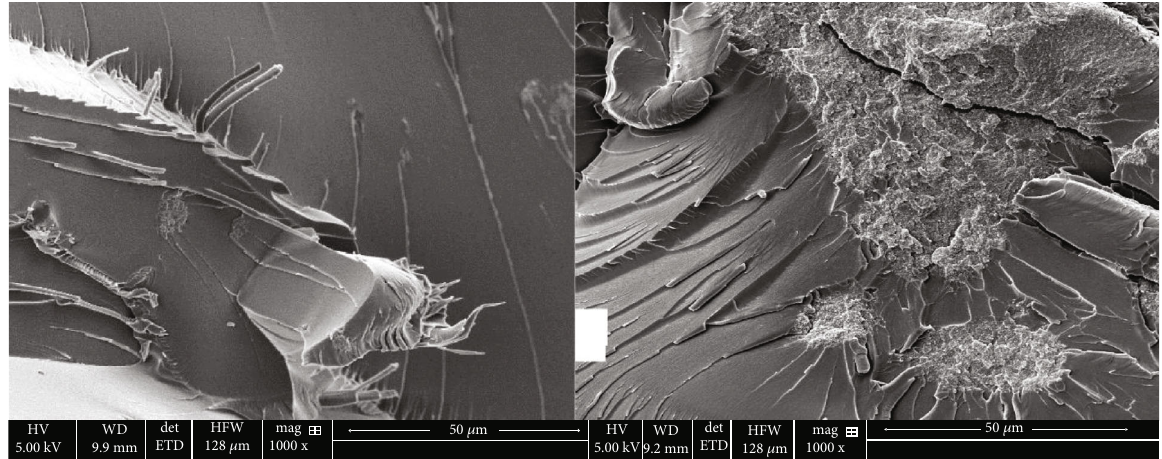
Figure 19: Fracture surfaces due to tensile failure in a 1.5wt.% MWCNT-reinforced epoxy composite subjected to 3000 thermal cycles.